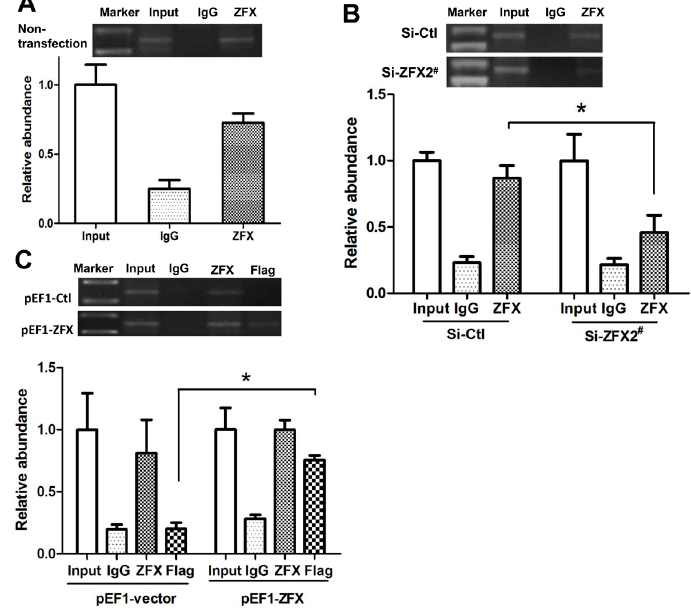
Figure 6. Binding of ZFX to the SET transcript 2 promoter confirmed with ChIP assay. ChIP experiments were conducted using ZFX antibody (2 µg) or Flag antibody (2 µg). In ( A – C ), the top panels show representative results of ChIP. The bottom panels present results of densitometry analysis based on three independent experiments. ZFX-binding results were standardized by those of input, setting the input value as 1. Data is presented as means ± SD from three independent experiments. (*, p < 0.01). ( A ) When untransfected HeLa cells were used in the ChIP assay, ZFX binding to endogenous SET promoter was readily detected; ( B ) Upon ZFX knockdown using Si-ZFX2 # , a significant reduction in ZFX binding to endogenous SET promoter was observed; ( C ) ZFX binding to endogenous SET promoter was detected in cells transfected with ZFX-expressing pEF1-ZFX or control pEF1-vector, and Flag antibody detected a strong binding of SET promoter by overexpressed ZFX.